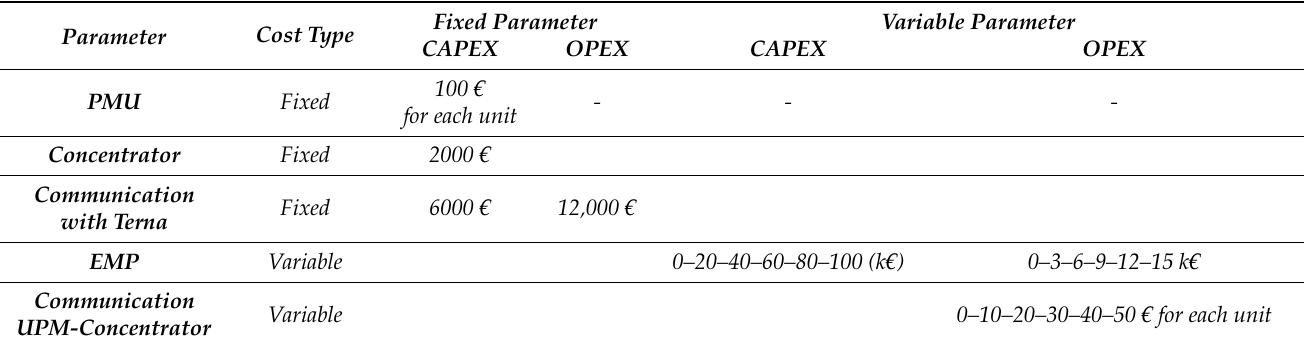
Table 1. Costs supported by the aggregator.